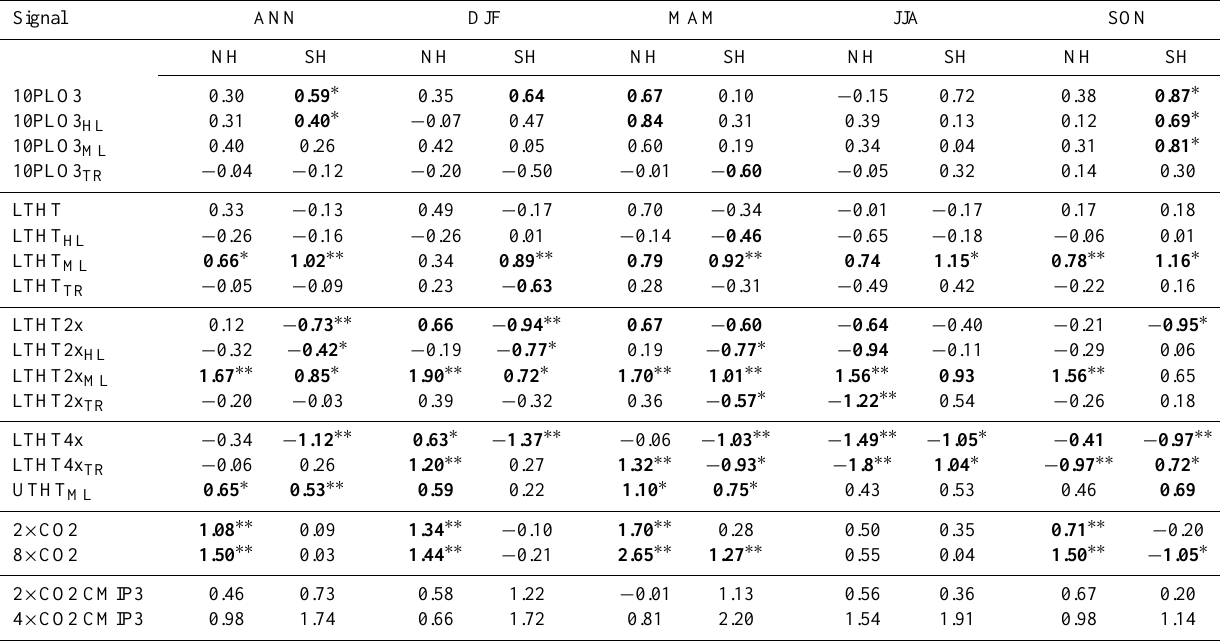
Table 4. Tropospheric (850–300hPa) poleward jet displacements for the (top) stratospheric cooling experiments and (middle and bottom) tropospheric heating/global warming experiments. Units are degrees latitude. CAM experiment significance is based on a Student’s t -test and is denoted by bold ( ≥ 90%); * ( ≥ 95%) and ** ( ≥ 99%). Also included is the corresponding jet displacement based on the ensemble mean of 12 CMIP3 2 × CO2 equilibrium experiments and 10 CMIP3 4 × CO2 transient experiments.